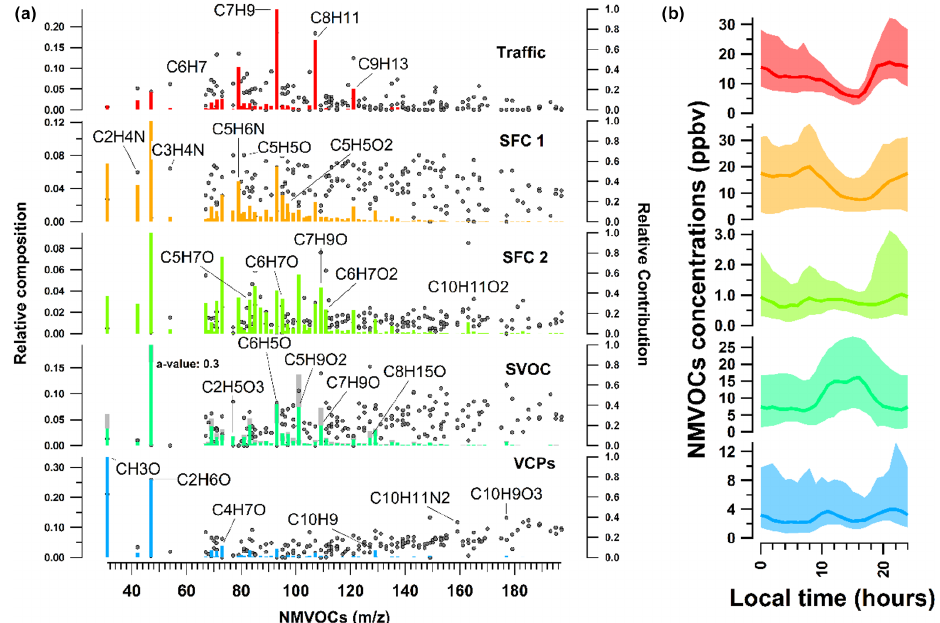
Figure 5. Profile and diurnal variation of individual factors of the selected five-factor solution after PMF analysis at Lucknow for the whole study period. In panel (a) , the left axis represents the relative composition of each factor, given by the vertical bars. The sum of all the bars at different m/z for each factor is 1, and the right axis represents the relative contribution of each factor to a given m/z , shown as grey dots. The grey bars in the SVOC factor represent the degree of constraint on the known source profile and time series. In panel (b) the middle dark line represents the median of the diurnal, while the shaded region represents the interquartile ranges from the 25th to 75th